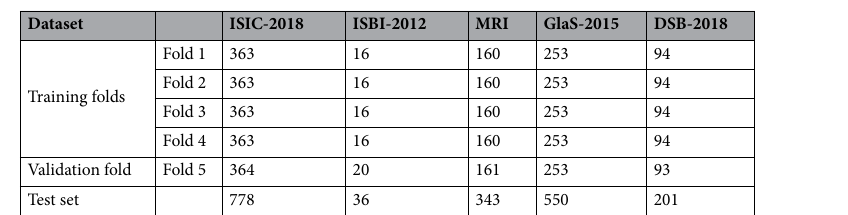
Table 2. The dataset splitting protocol followed in this study. Each dataset is first partitioned into the training and the test sets. The training set is further split in a 5-fold CV, where 4-folds are used for training and the last fold for validation. The test set is used to evaluate each model against the 5-folds and then, the mean value is computed as the final segmentation performance of each model. For ISBI-2012 and GlaS-2015 datasets, we have used patch-wise training to increase the number of data